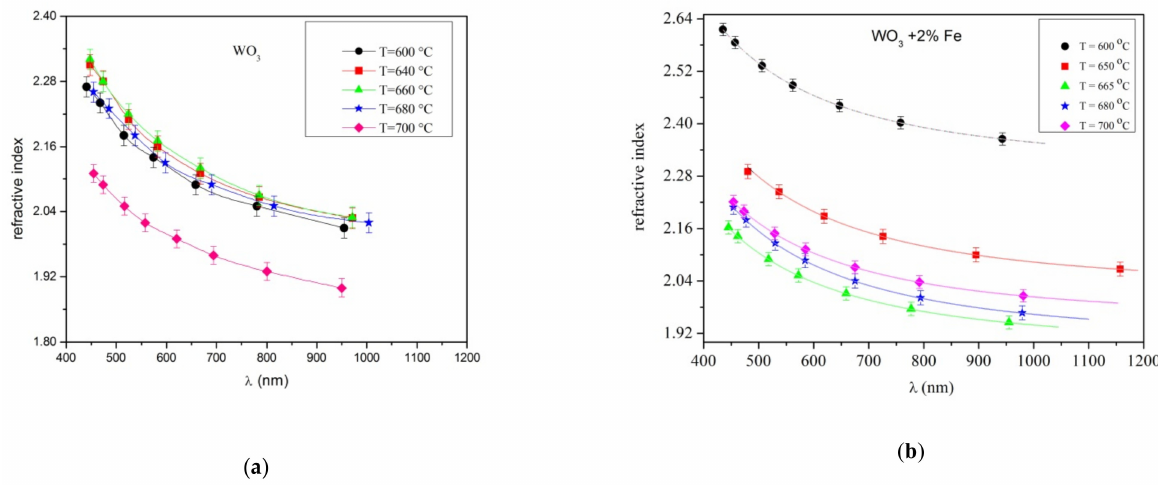
Figure 8. The refractive index depending on the substrate temperatures. ( a ) pure WO 3 layer; ( b ) 2% Fe doped WO 3 layer.